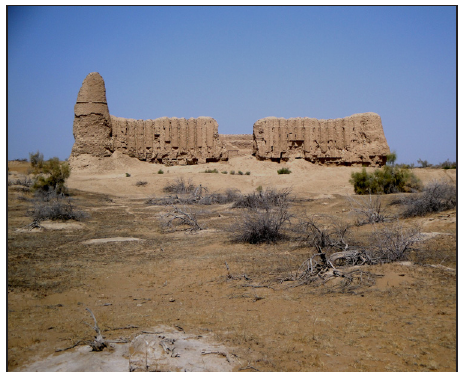
Figure 2: Tumsukly Minara caravansary (Turkmenistan) with central entrance (largely collapsed) and minaret (left). (Photo: Annamyrat